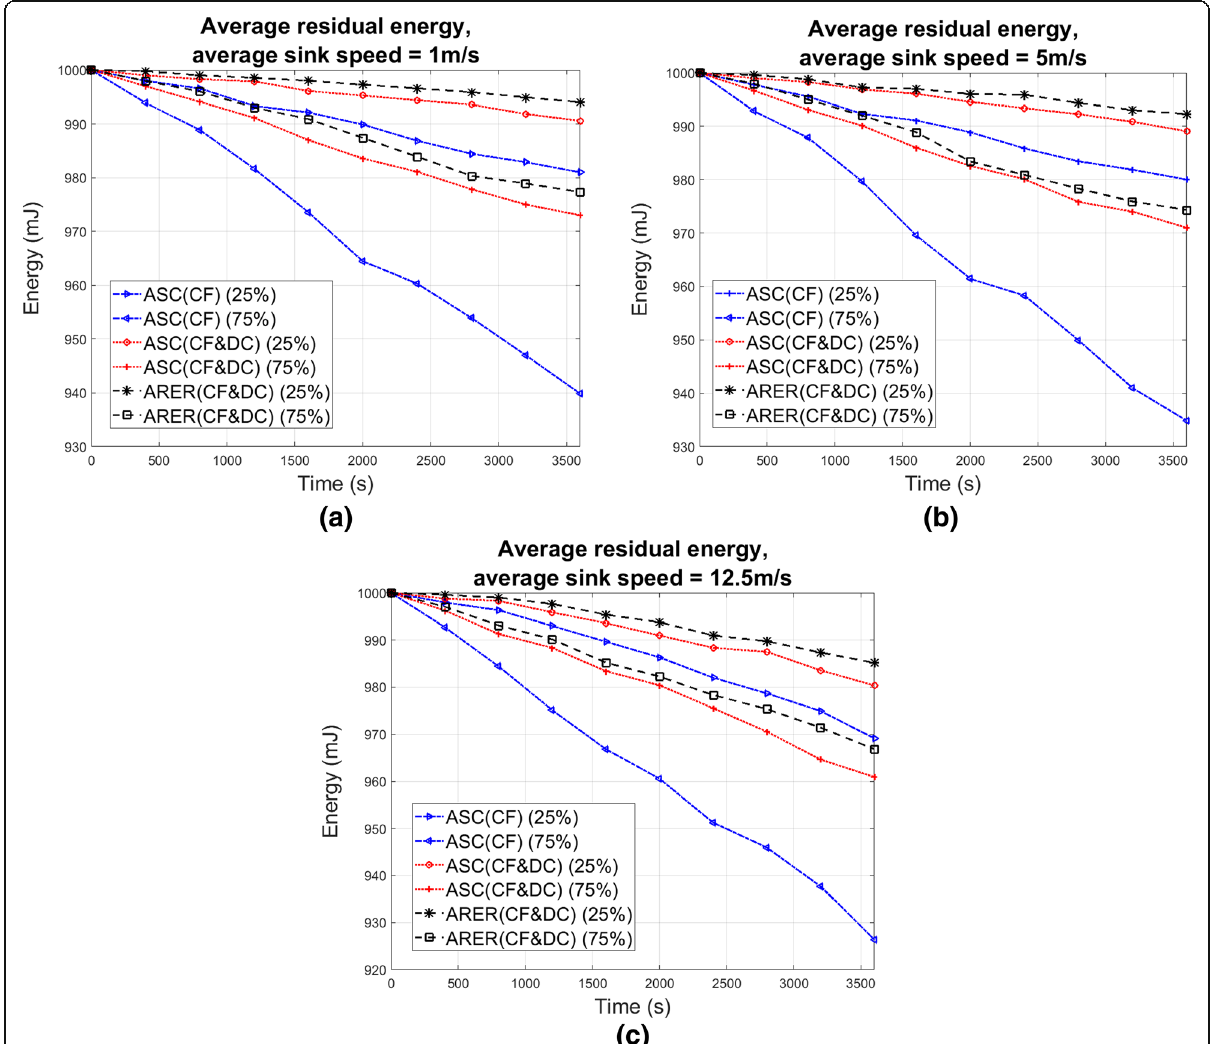
Fig. 5 Average residual energy of the network with different speeds of the sink. a Average sink speed 1 m/s. b Average sink speed 5 m/s. c Average sink speed 12.5